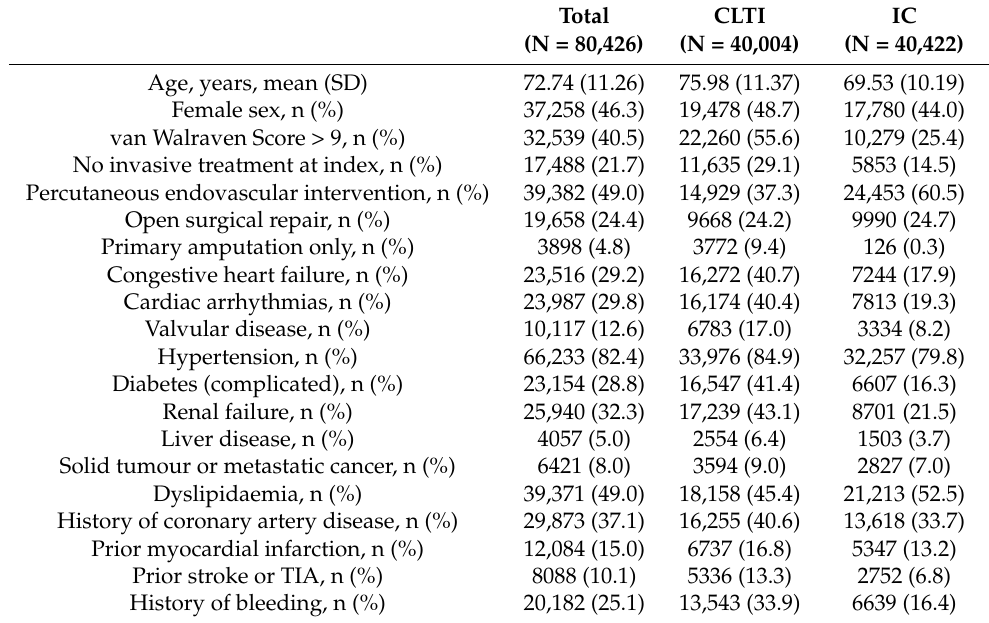
Table 1. Baseline characteristics of the total study cohort and CLTI and IC patients. SD: Standard Deviation; TIA: Transient ischaemic attack; CLTI: Chronic limb-threatening ischaemia, IC: Intermittent